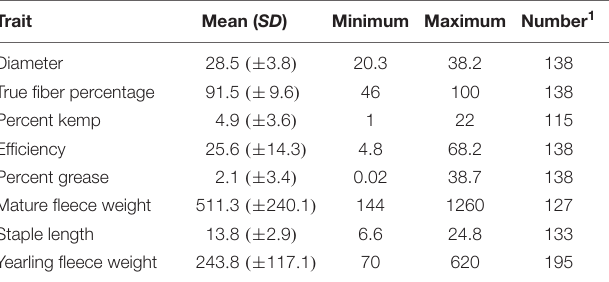
TABLE 2 | Descriptive statistics for the mohair traits evaluated.